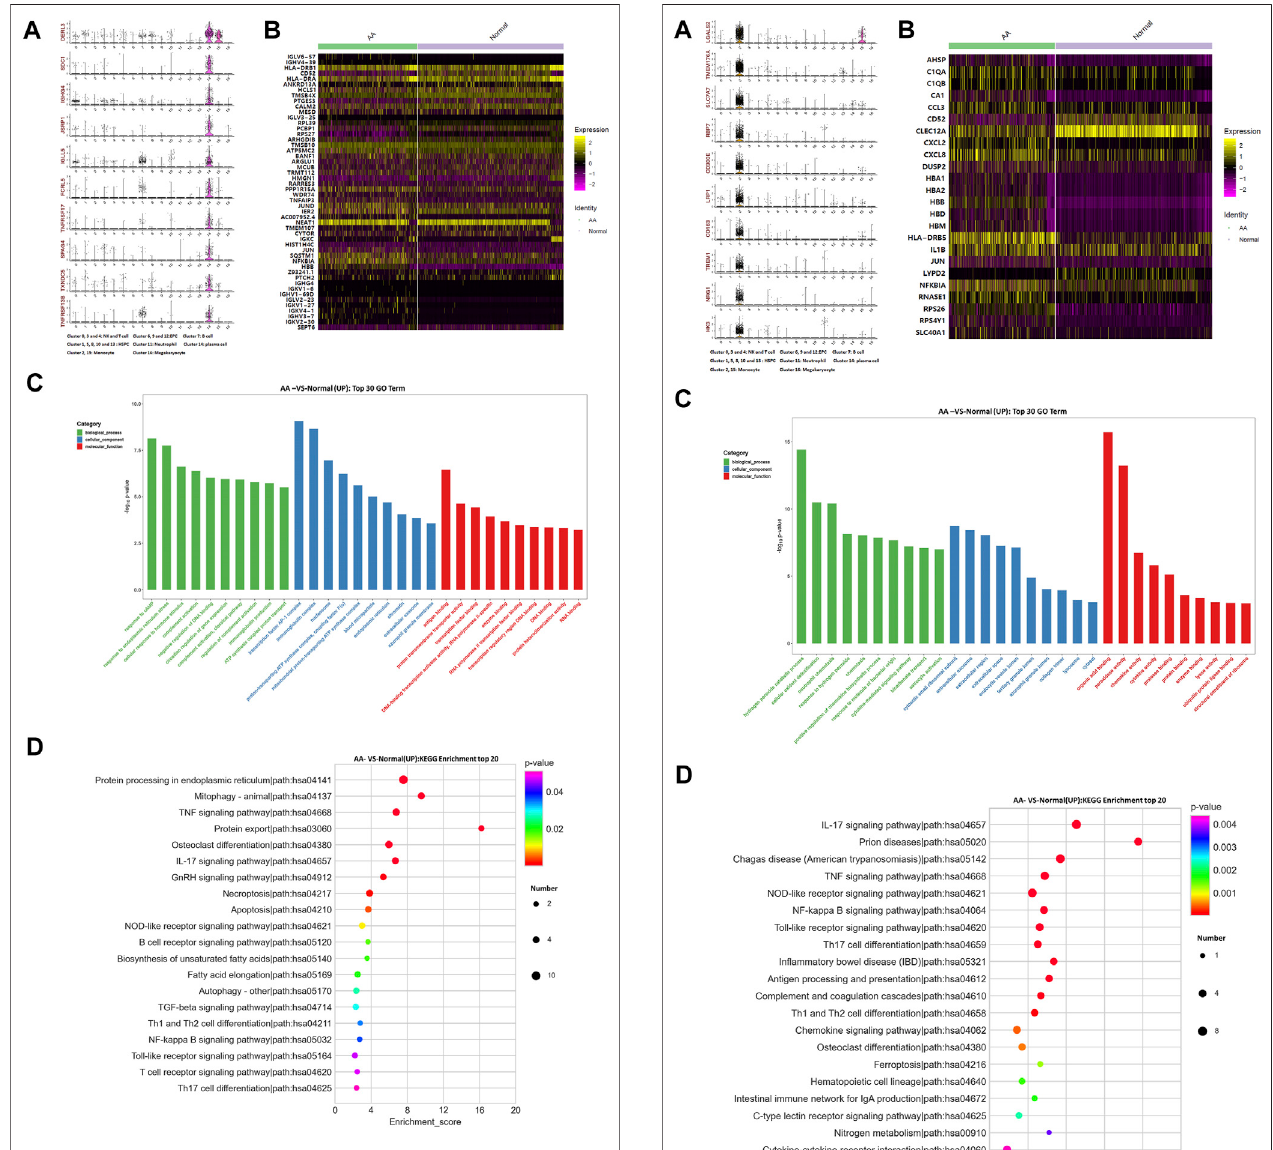
FIGURE 4 | Gene alterations in plasma cells from AA patients. (A) Violin plot of the top 10 marker genes in monocytes. (B) Heatmap of differentially expressed genes in monocytes. (C) GO analysis of upregulated genes in monocytes. (D) KEGG pathway of upregulated genes in monocytes. FIGURE 5 | Gene alterations in monocytes from AA patients. (A) Violin